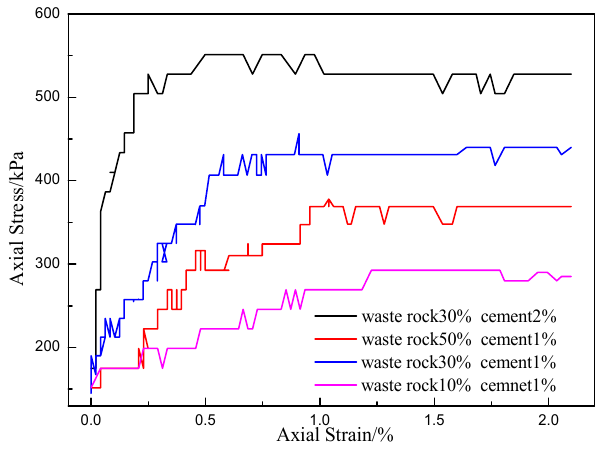
Figure 7 Stress-strain curves of the disposal in different ratios.